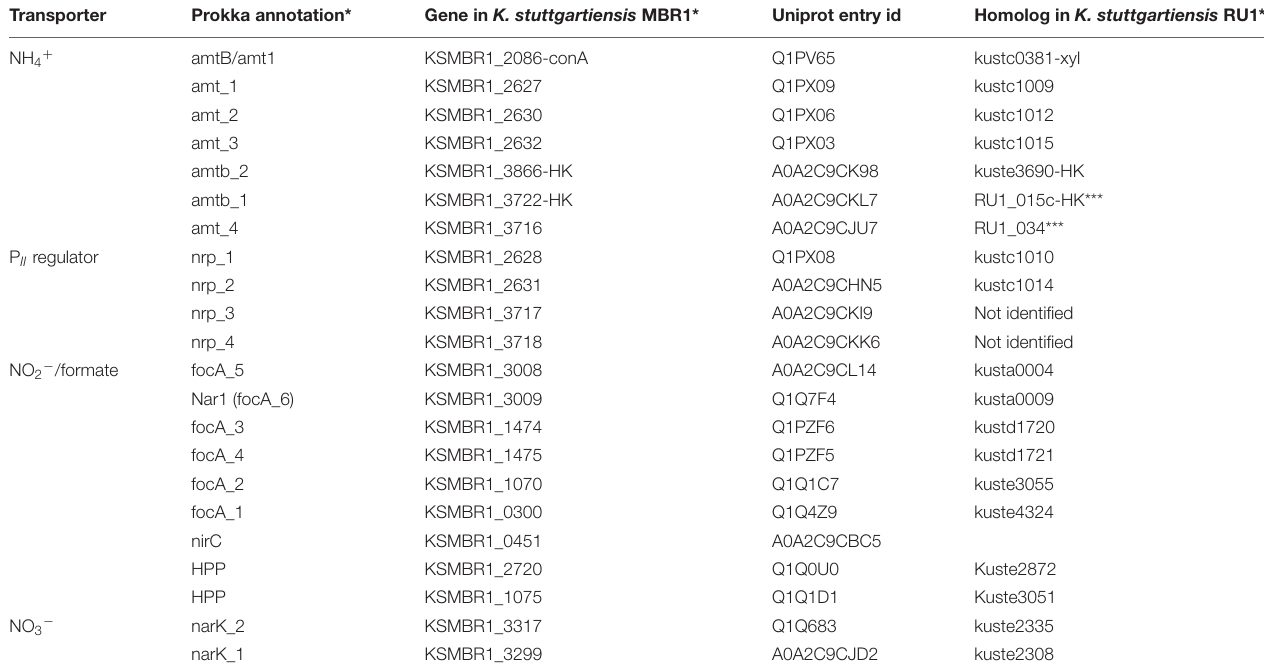
TABLE 1 | Nutrient transporter genes in the anammox bacterium K. stuttgartiensis